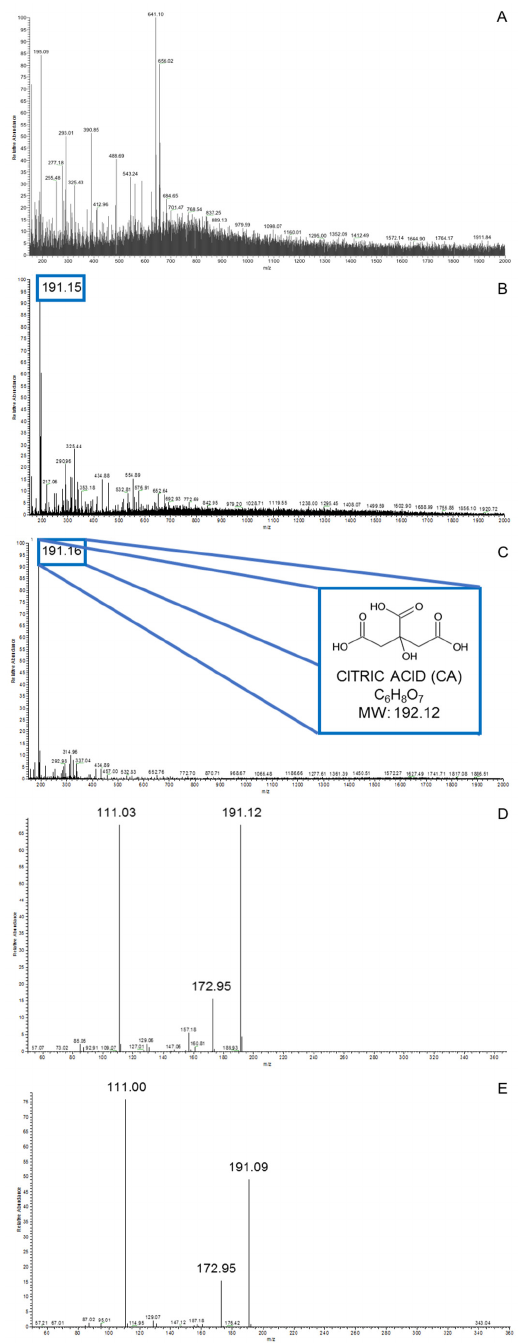
Figure 2. Negative ionization ESI-MS analysis of the non-fermented substrate extract (negative control) ( A ) and biological ( B ) and commercial ( C ) solutions of CA. Fragmentation pattern analysis (normalized collision energy = 20.00) validated the peak association to CA in the biological sample ( D ) compared with the commercial one ( E